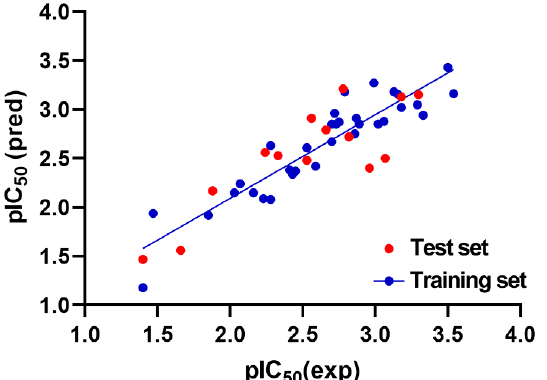
Figure 1. Relationship between the predicted p IC 50 values and the experimental values of the train- activity relationship (3D-QSAR) atom-based approach.